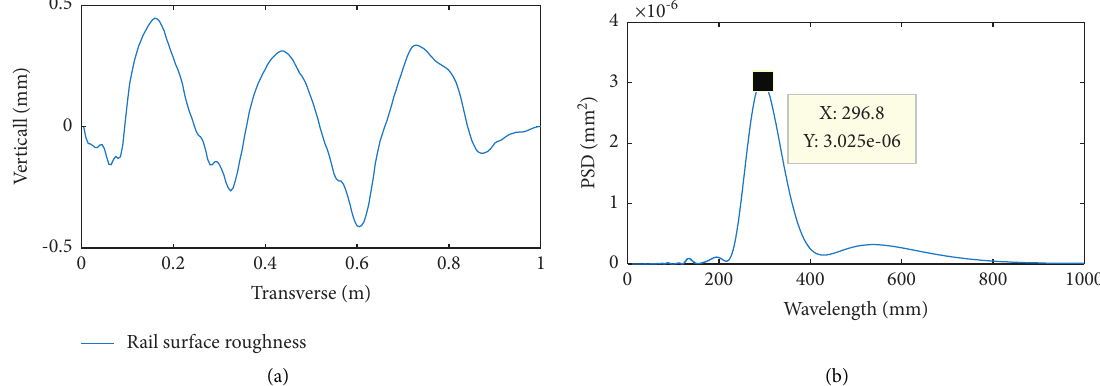
Figure 13: (a) The surface roughness of the rail surface. (b) The power